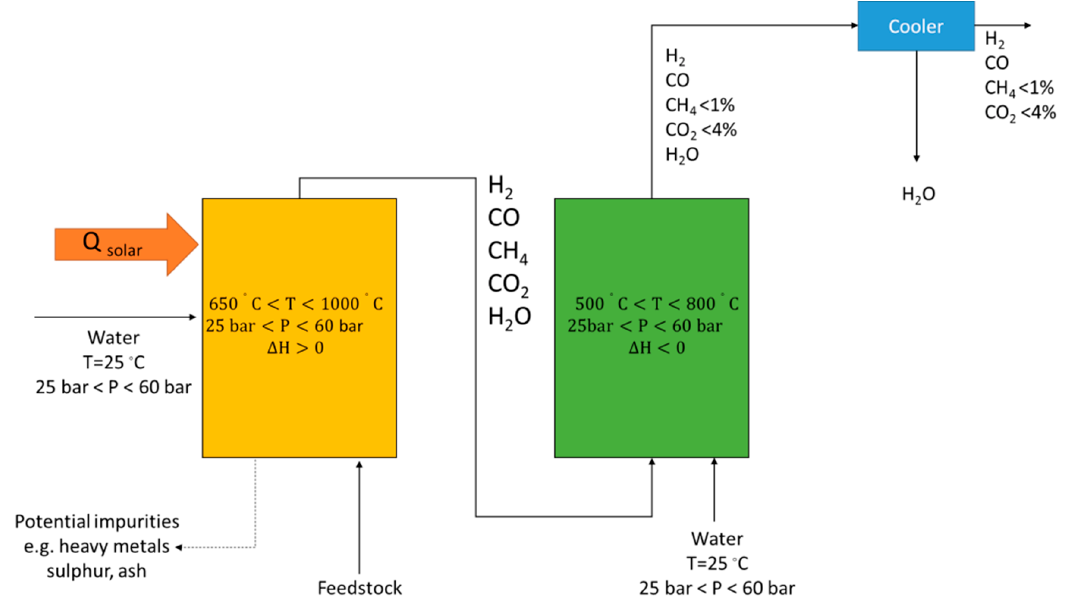
Figure1. Detailedoperatingconditionsofthe processfor supercriticalsyntheticgas (syngas)production. Figure 1. Detailed operating conditions of the process for supercritical synthetic gas (syngas)